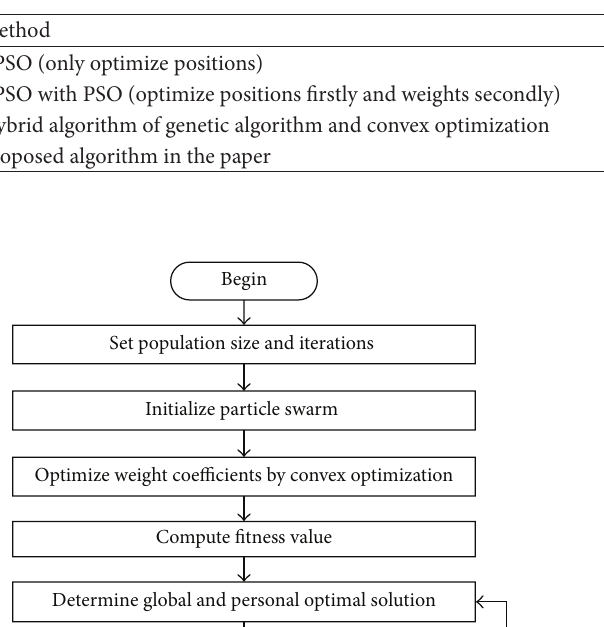
Table 1: PSLL and calculation time of different methods.